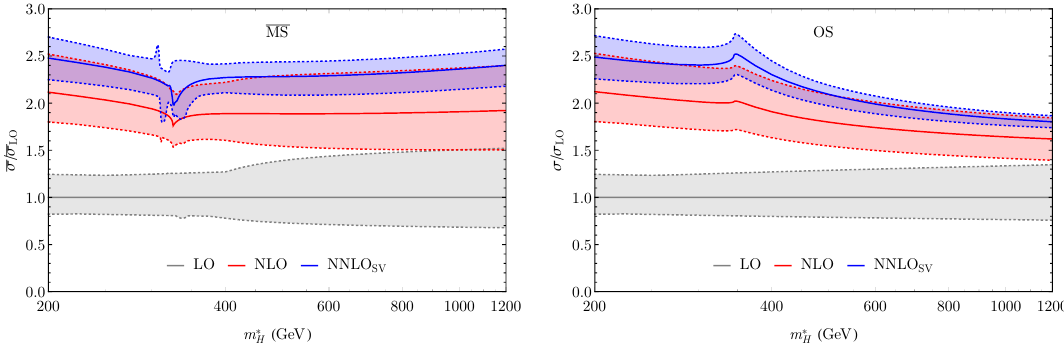
Figure 3 . K -factors in the MS (left) and OS (right) schemes, as a function of m ∗ LO (gray), NLO (red) and NNLO SV (blue) are shown, together with the corresponding uncertainty bands. The central scale µ 0 = m ∗ / 2 is always used in the H